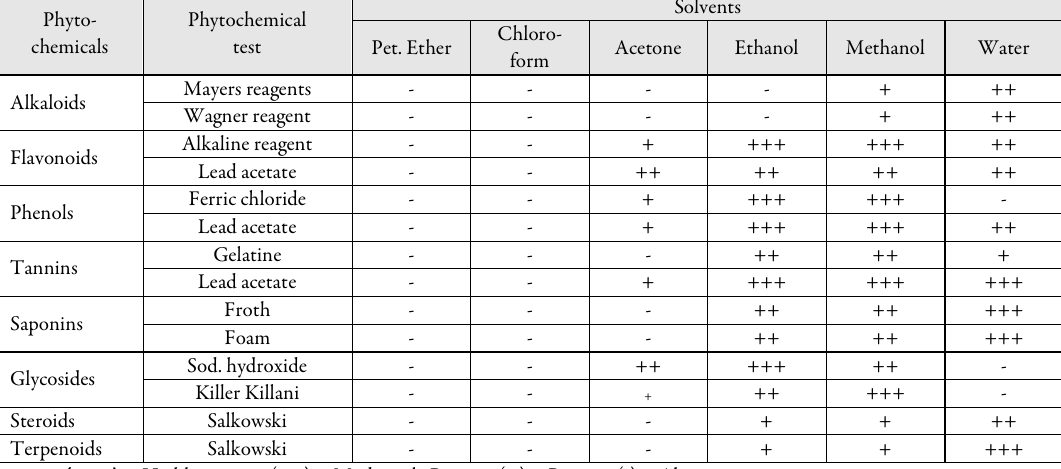
Table 1. Preliminary phytochemical screening of leaves extracts of Mucuna pruriens (L.) DC. Phyto-